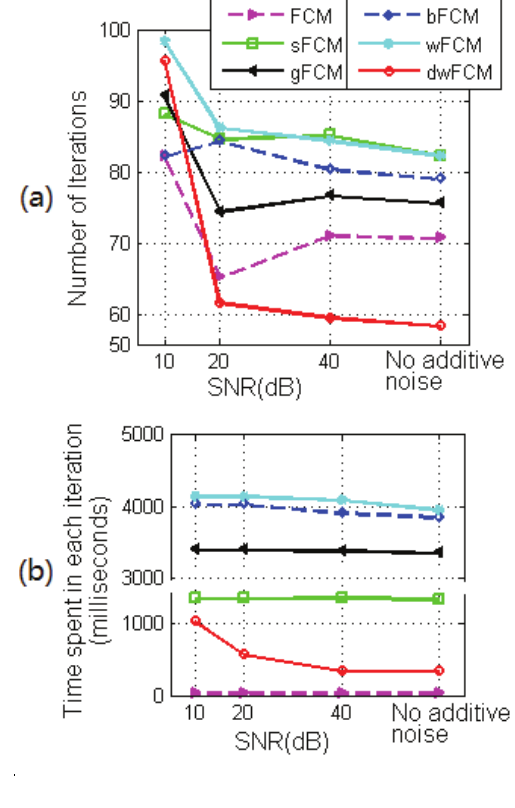
Fig. 5. Results of (a) iteration times; (b) time spent on each iteration by FCM variants with image data with additive Ri- cian noise of different SNR